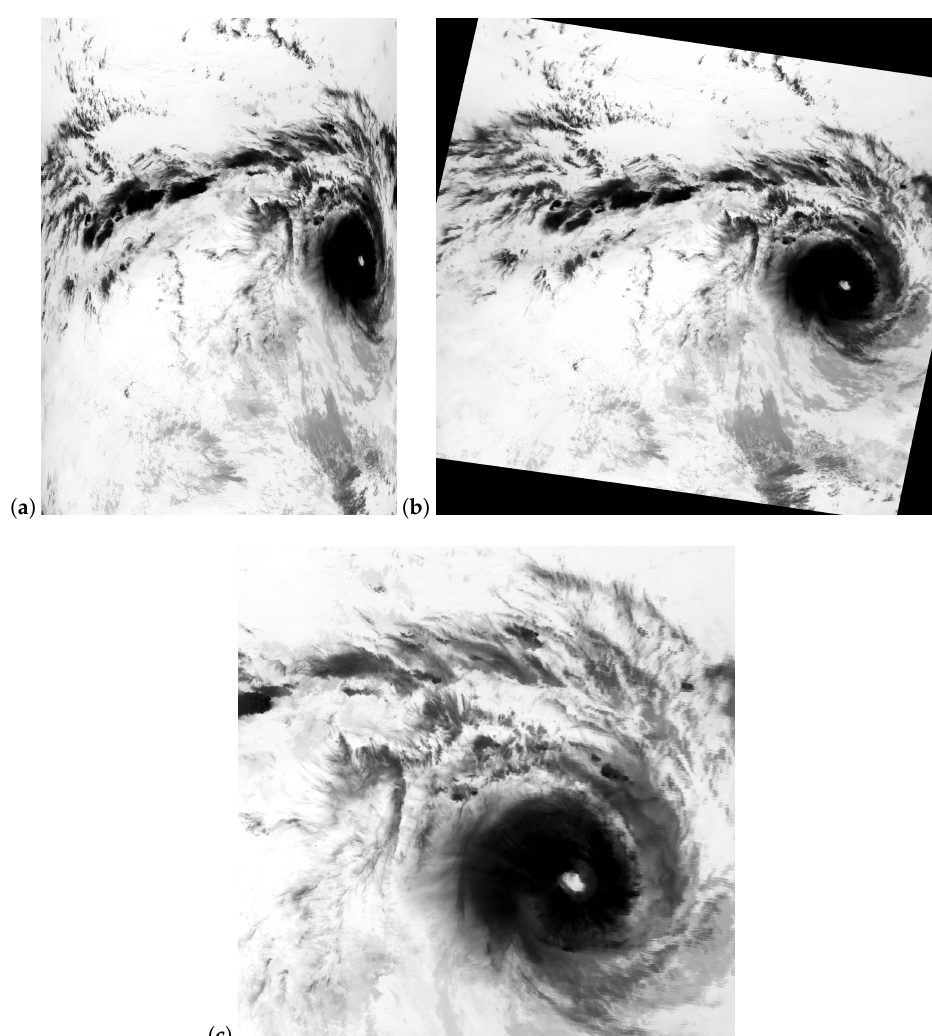
Figure 12. Sequence of pre-processing steps of the MODIS-Terra image of 05.20 UTC on 8 February 2021: the raw MODIS image is first displayed ( a ), before the georeference processing ( b ), and after it is resized and centered on cyclonic system ( c ). Scene coordinates: from left to right on the top (74.16 ◦ E, 7.20 ◦ S)–(84.38 ◦ E, 7.13 ◦ S), on the bottom (74.15 ◦ E, 16.3 ◦ S)–(84.56 ◦ E, 15.37 ◦